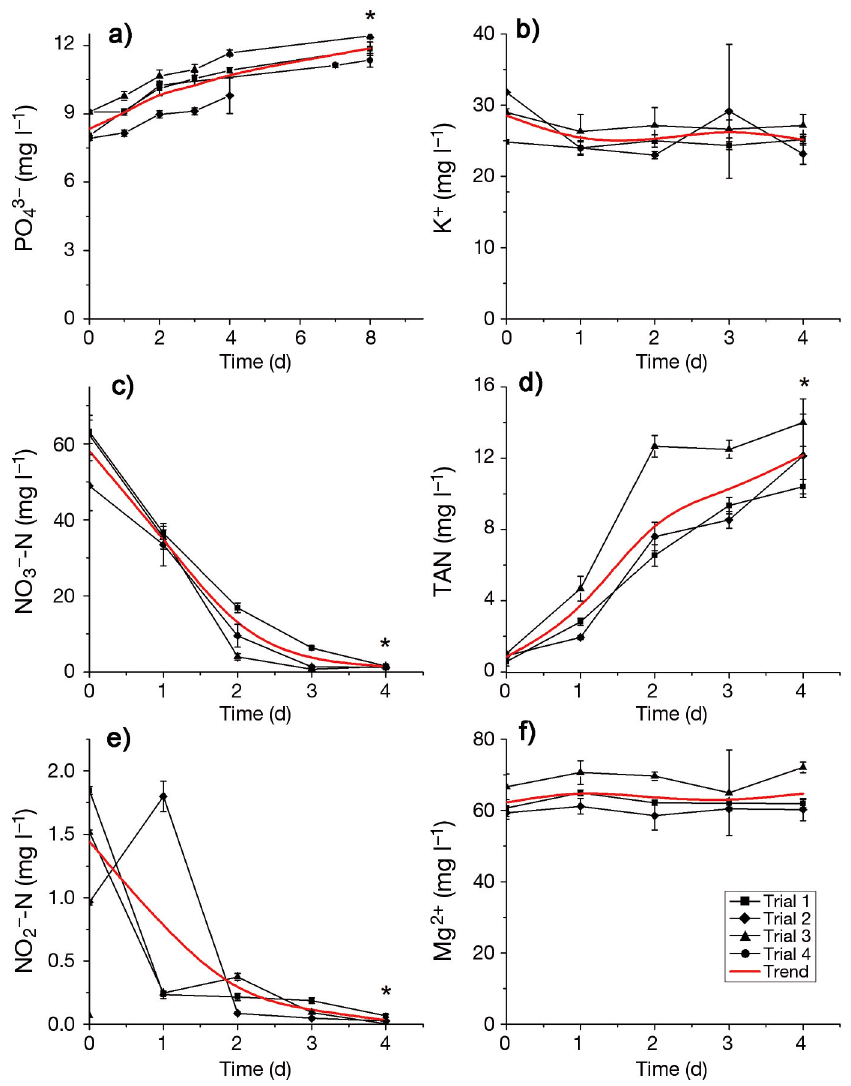
Fig. 2. Soluble nutrients (PO 43− , K + , total ammonia nitrogen [TAN], NO 3− -N, NO 2− -N, Mg 2+ ) in the liquid phase of a water- sludge mixture derived from a tilapia recirculating aquaculture system over 4 d (8 d only for soluble reactive phosphorus, PO 43− ) of anaerobic mobilization (Expt 1). Data from 3 successive trials (4 trials for soluble reactive phosphorus PO 43− ) are pre- sented as mean ± SD. Trend lines: means of the successive trials (technical replicates). *Significant differences compared to Day 0 are indicated by an asterisk (p < 0.05, Dunn’s test, n = 3 or 4